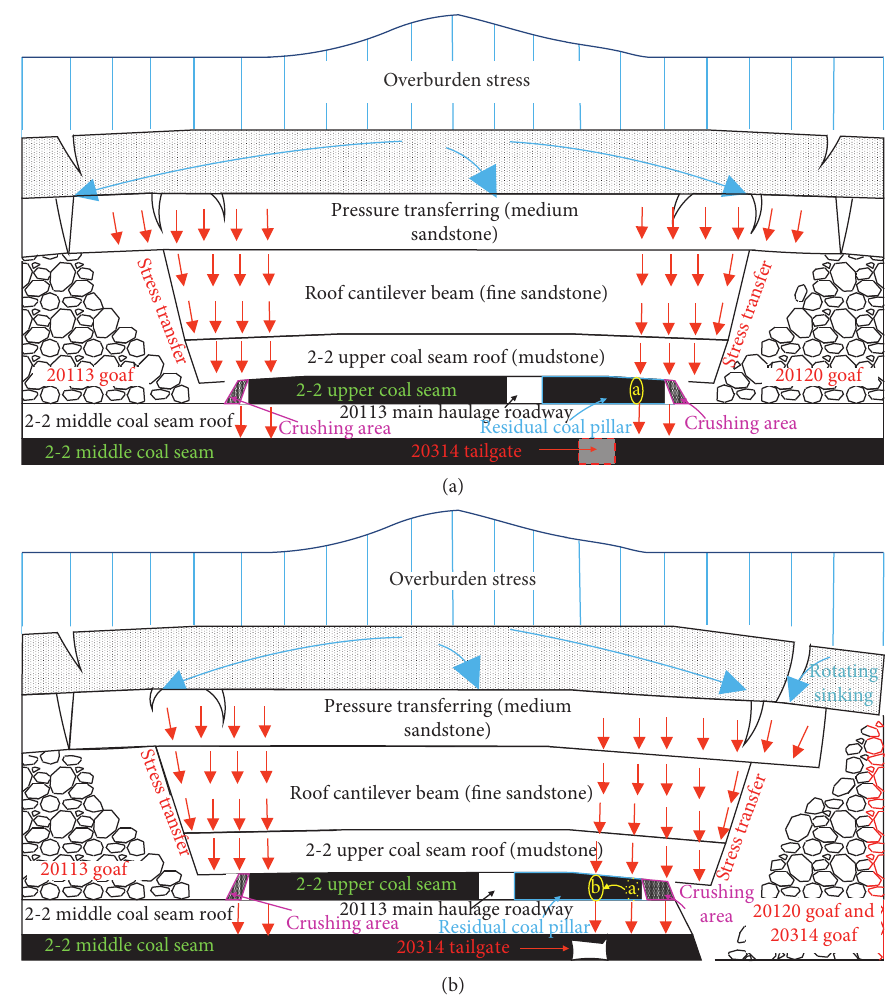
Figure 15: Stress changes under the coal pillar: (a) excavation of the 2-2 upper coal seam; (b) excavation of the P20314 working